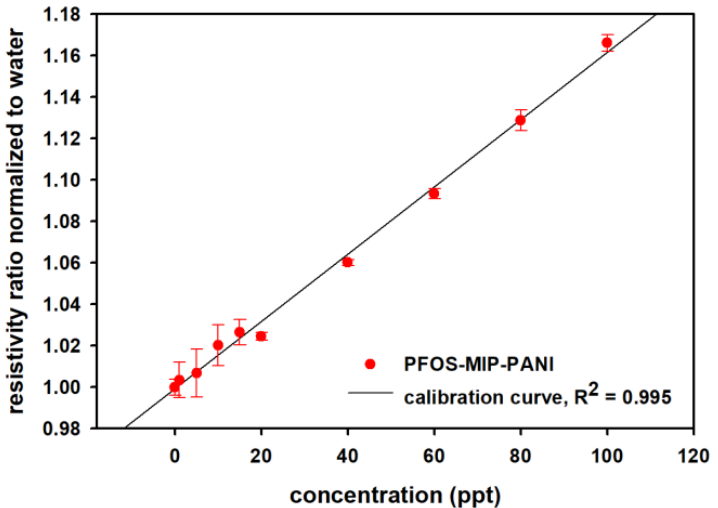
Figure 5. The calibration curve of PFOS-MIP-PANI exposed to various concentrations of PFOS aqueous solutions. The resistivity ratios were normalized to the resistivity ratio of DI water. The data points denote the averages of repeating measurements of DC resistance of at least three devices, from which